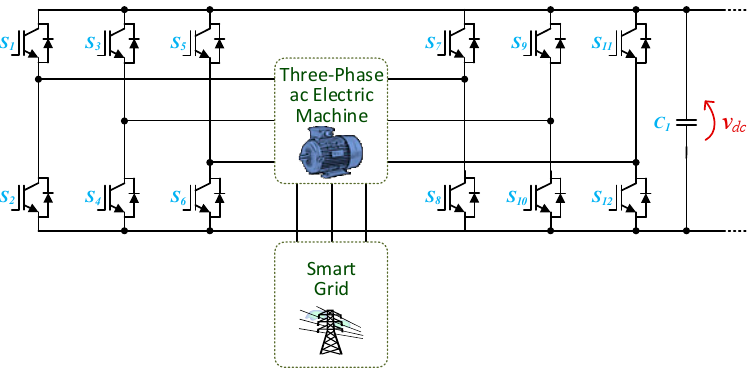
Figure 26. Unified power converter topology based on an open-end winding permanent magnet synchronous machine with split windings and two power converters.